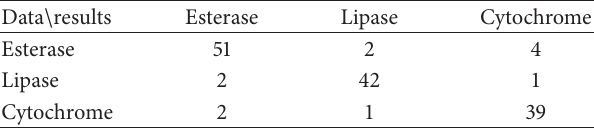
Table 9: Confusion matrix obtained using neural network classifier on dataset 3.